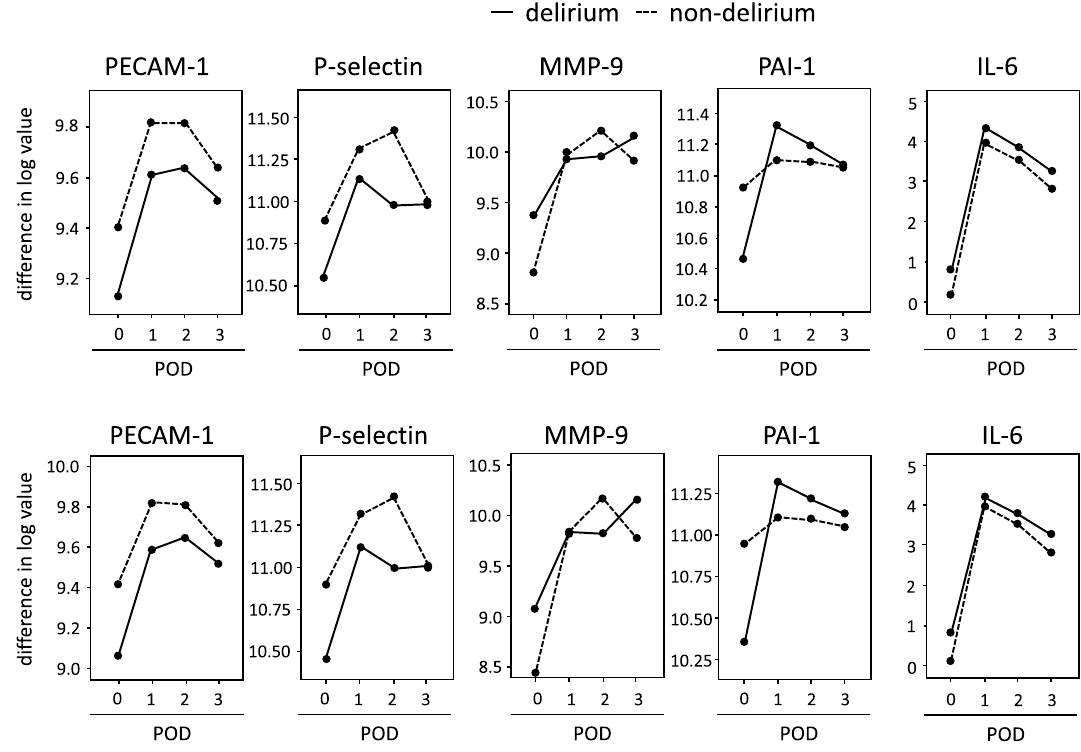
Figure 2. Changes in the serum levels of potential biomarkers for delirium. Preoperative (POD 0) values of PAI-1, MMP-9, P-selectin, PECAM-1, and IL-6 originated from the same dataset published in Ref. 12 . Delirium, solid line; dotted line, delirium. Upper panels, no covariate; lower panels, age as a covariate. Sample size at each point is indicated in online Supporting Information Table S2. POD, postoperative day; pNF-H, phosphorylated